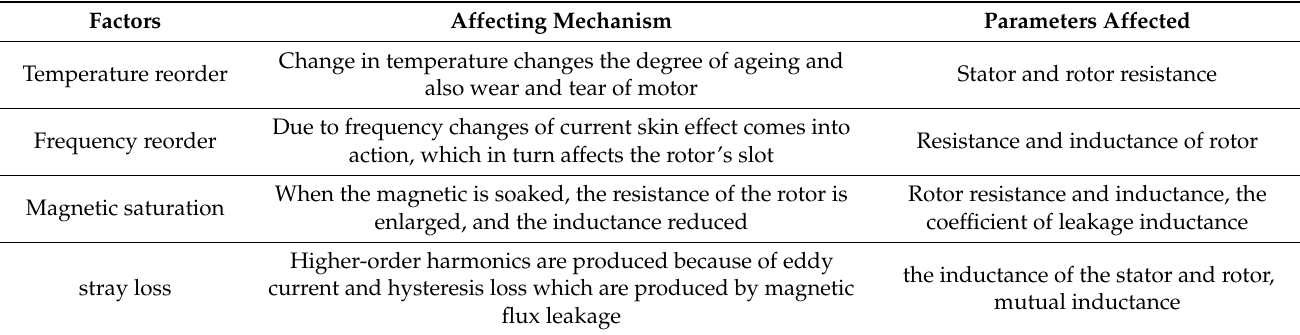
Table 1. Factors that agitate the parameters of induction